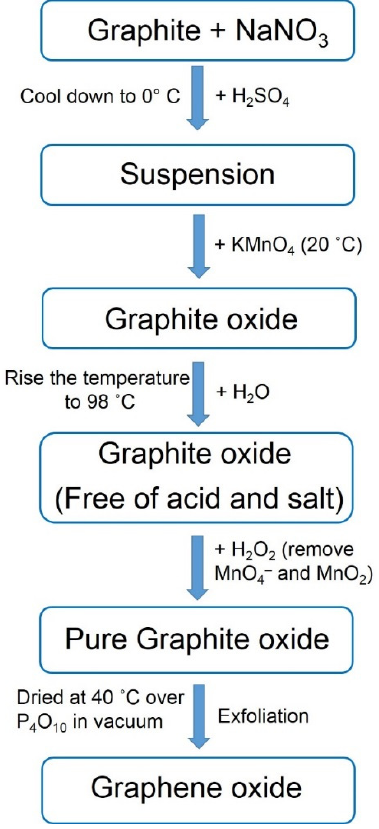
Figure 6. Schematic diagram showing Hummers method [31].